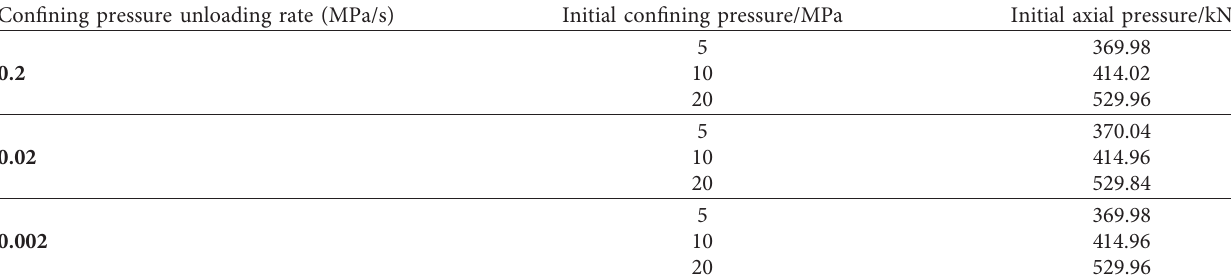
Figure 4: Relationship between σ 3 and σ 1 at different unloading confining pressure rates. Table 1: Initial unloading state of rock